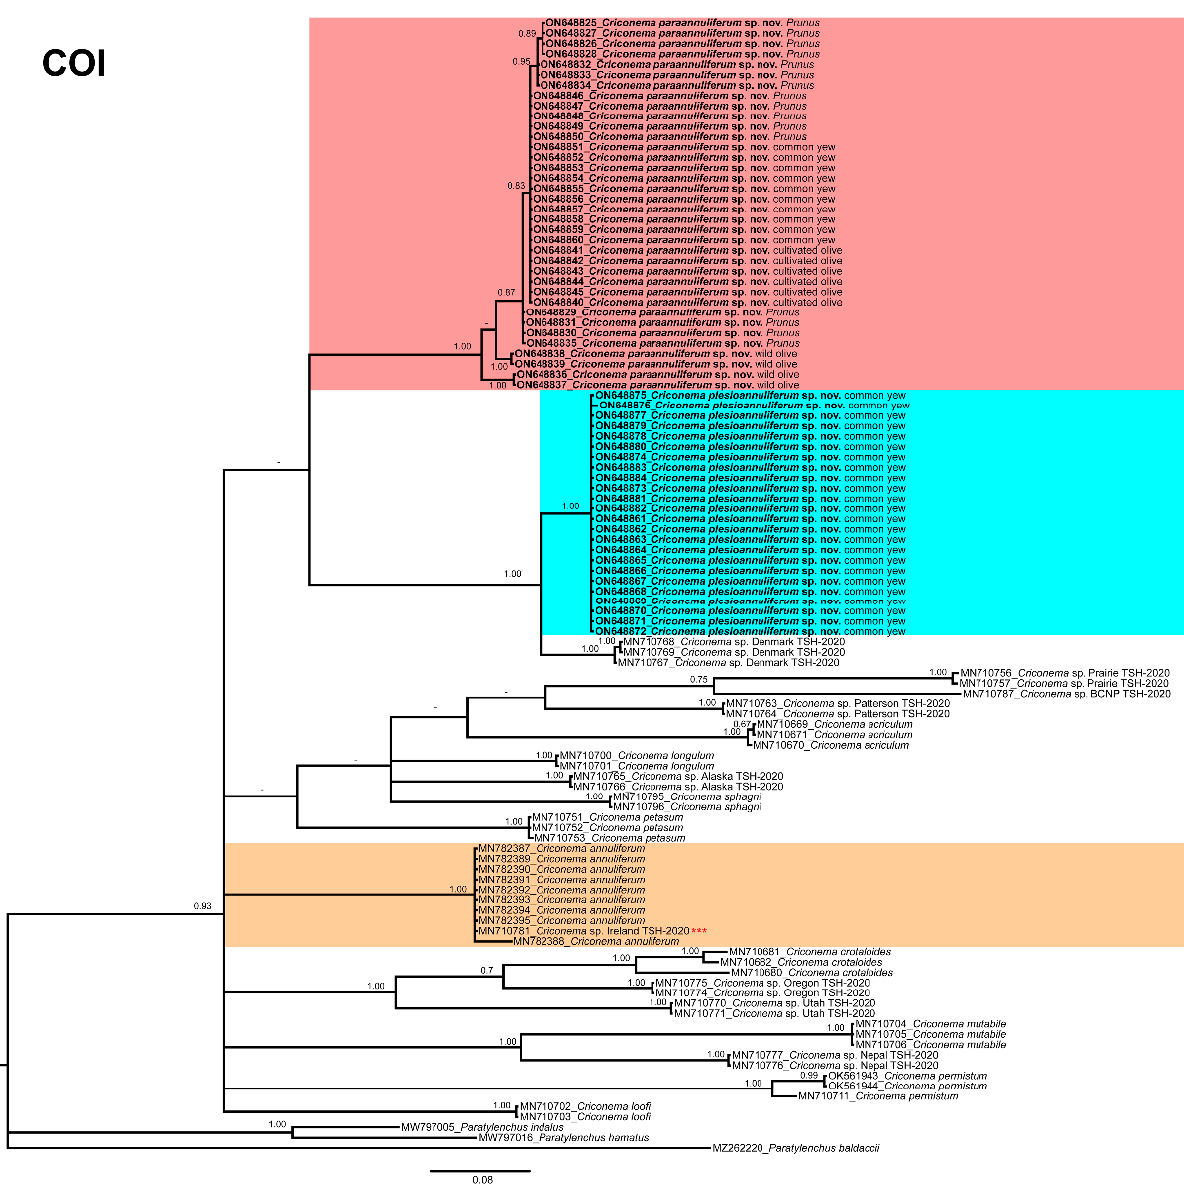
Figure 16. Phylogenetic relationships within the genus Criconema . Bayesian 50% majority rule consensus tree as inferred from cytochrome c oxidase subunit 1 (COI) sequence alignment under the three-parameter model with invariable sites and gamma distribution model (TPM3uf + I + G). Posterior probabilities of more than 0.70 are given for appropriate clades. Newly obtained sequences in this study are in bold. The scale bar indicates expected changes per site, and the coloured boxes indicate the clade association of the Criconema annuliferum -complex. *** Criconema sp. Ireland TSH2020 should be considered to be C. annuliferum .